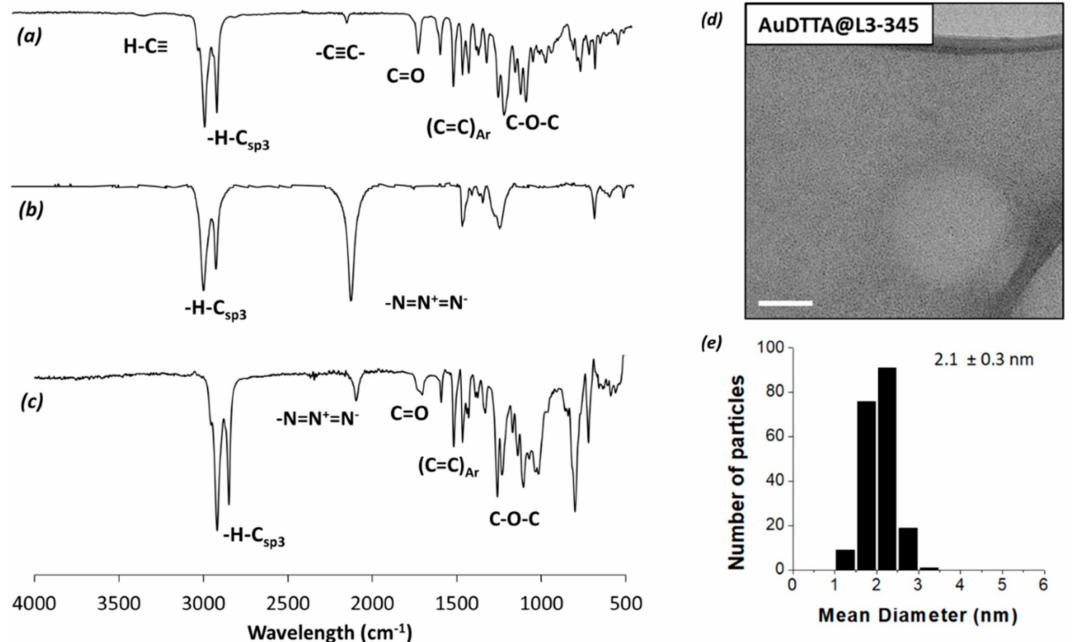
Figure 3. ATR-FTIR spectra at 25 ◦ C of: ( a ) alkyne-focal point ligand L3-3,4,5, ( b ) AuDT-AT nanopar- ticle, and ( c ) AuDT-AT-TA@L3-3,4,5 nanoparticles. ( d ) TEM micrograph (top-right) and ( e ) NP’s size distribution histogram (bottom-right) for AuDT-AT-TA@L3-3,4,5. In each TEM specimen, 200 to 250 particles at least have been measured from different microphotographs obtained from different areas of the